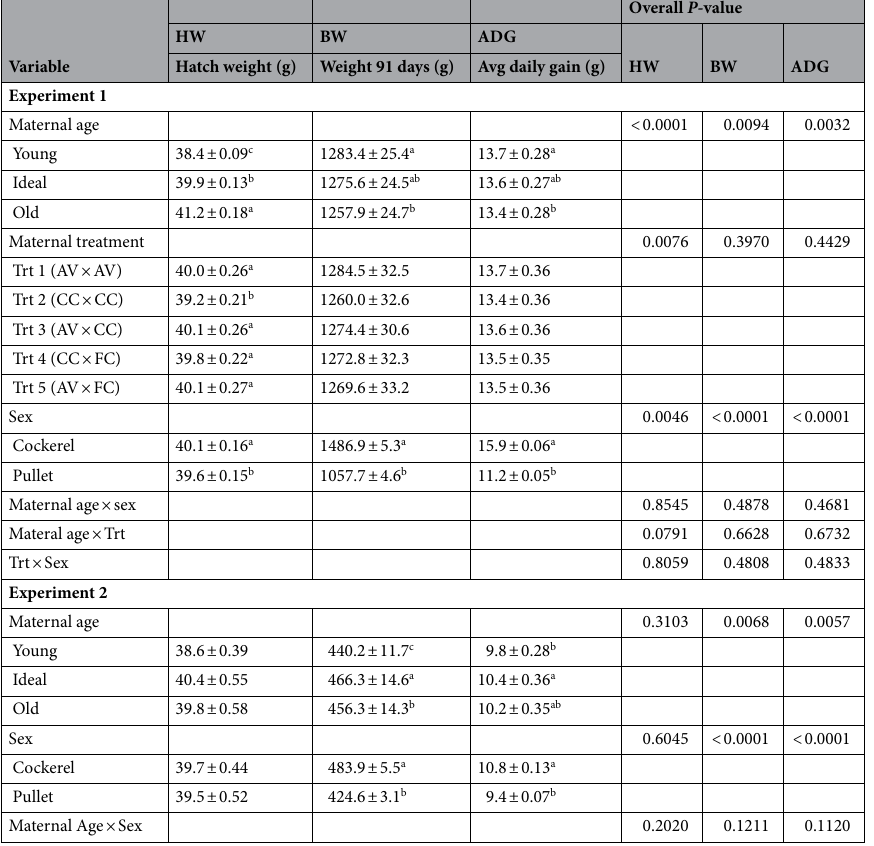
Table 2. Offspring growth. Means ± SEM for hatch weight, body weight, and average daily gain for progeny from Experiments 1 and 2. abc Values within a column for Maternal Age and Maternal Rearing × Adult Housing treatments with different superscripts differ P < 0.05.